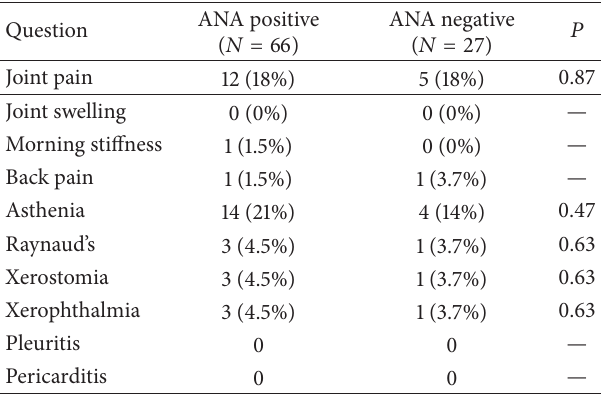
Table 3: Positive answers at questionnaire in ANA-positive and ANA-negative children with